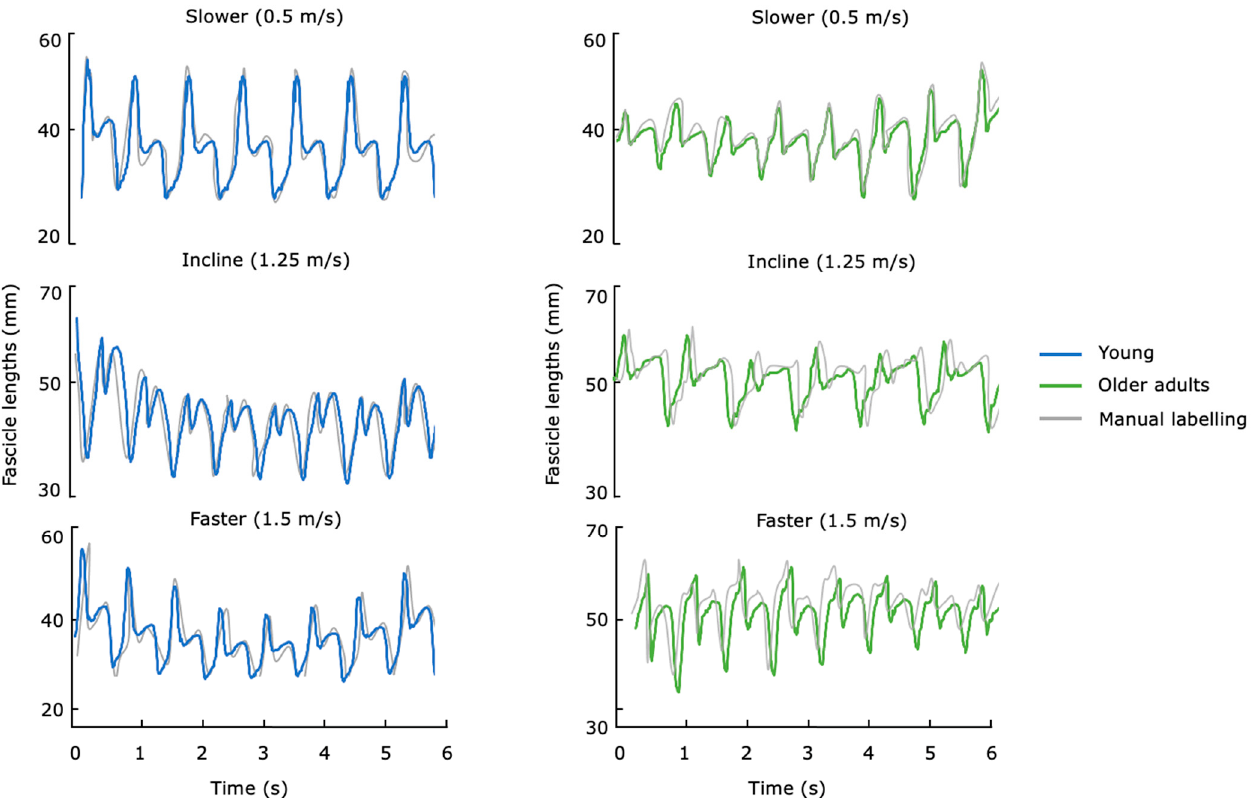
Figure 5. Fascicle lengths (in millimeters) versus time (in seconds) in output from the ResNet + 2x-LSTM algorithm for the all-age-trained model for both young and older adults compared against the (semiautomated) manual labeling. The time series data show the trends across three tasks, including level ground at walking speeds of 0.75 m/s (slower), 1.25 m/s at 10% incline, and 1.5 m/s (faster) of the muscle fascicles regressed from the B-mode ultrasound images.